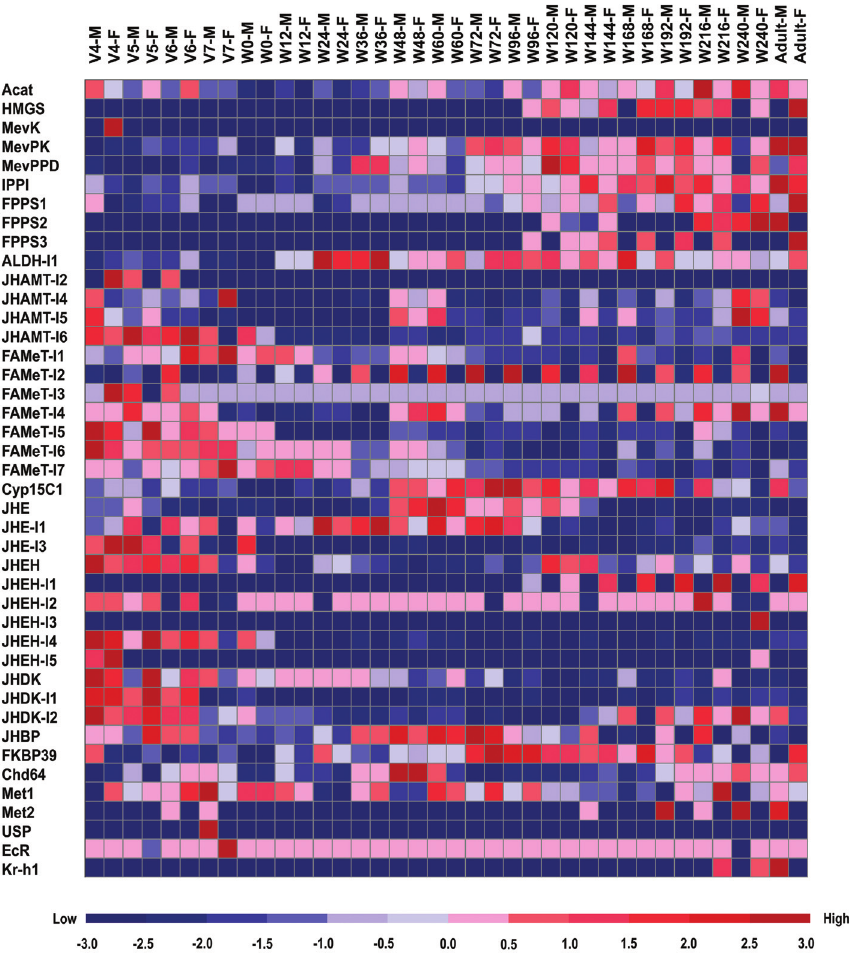
Figure 5 - Expression profiles of JH-related genes during metamorphosis in B. mori . The developmental expression profiles of JH-related genes for B. mori were analyzed using microarray data of genome-wide gene expressions at 19 time points during B. mori metamorphosis. The ratio was calculated by comparing the signal intensity of the mRNA expression level for each JH-related gene at each time point to that in the common reference of larvae on the third day of the fifth instar in B. mori. Subsequently, the expression change of each JH-related gene was evaluated by this expression ratio and visualized using the GeneCluster2.0 program. Plus and minus denote up- and down-regulation,